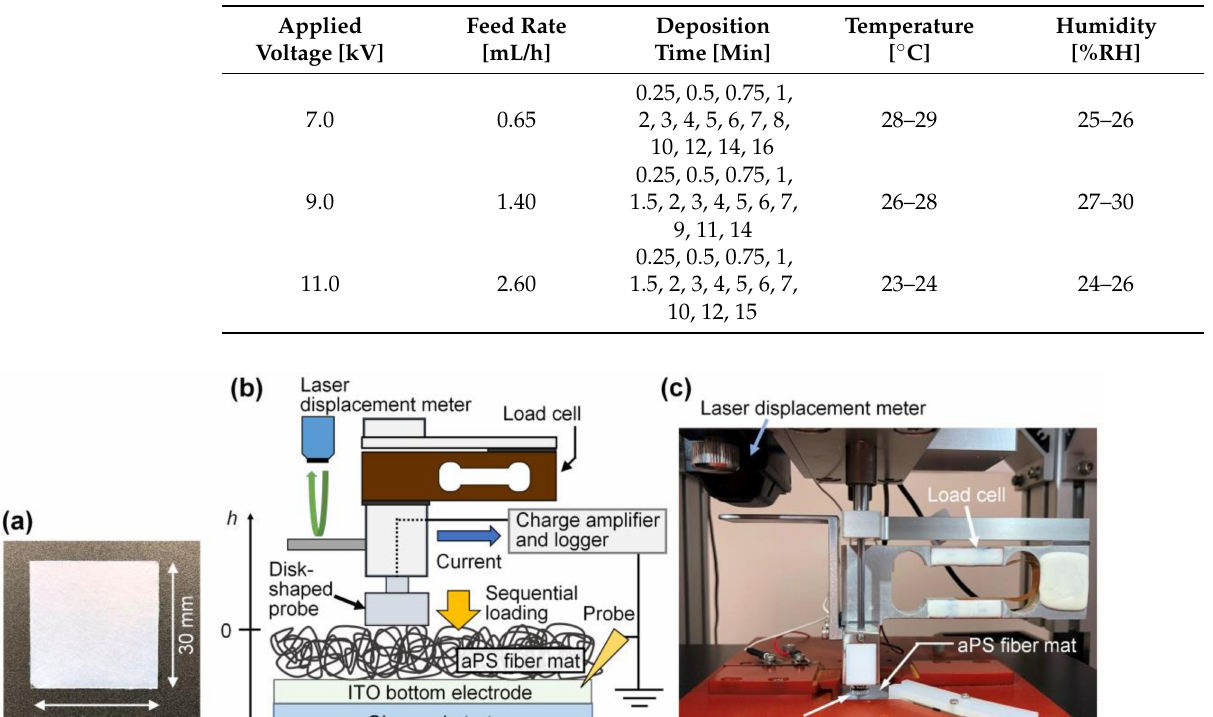
Table 1. Electrospinning conditions.